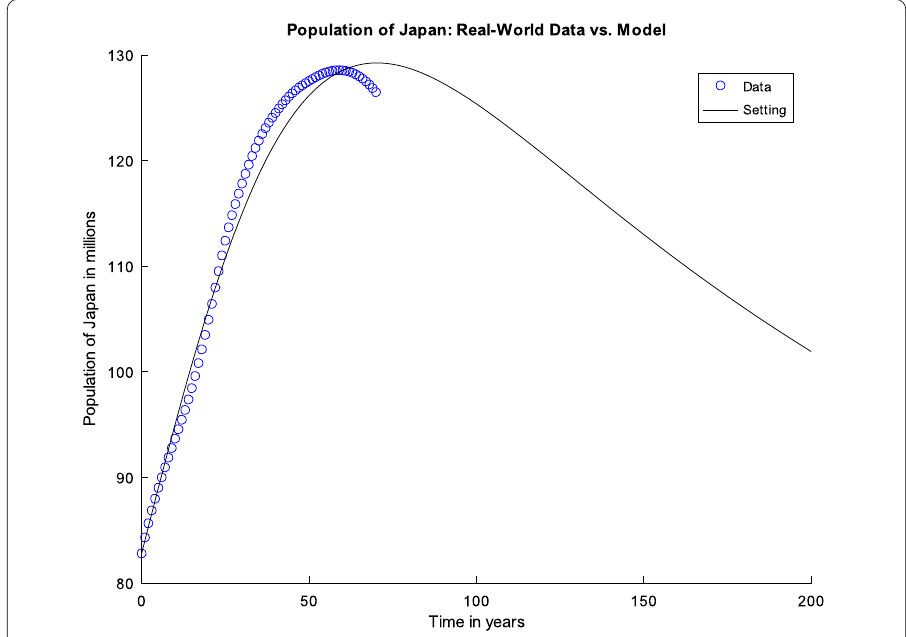
Figure 9 Results for our prediction of the Japanese population size. Here t = 0 corresponds to the year 1950, and t = 69 corresponds to the year 2019. This is the time frame for our data points